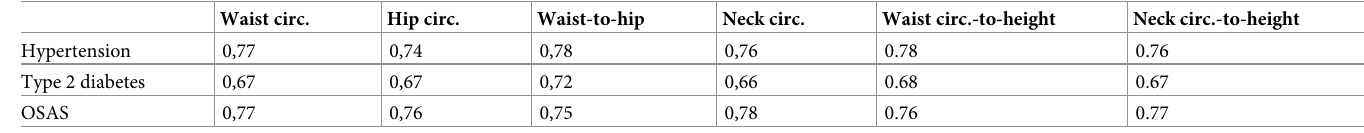
Table 2. Areas under the curve of univariate logistic regressions. Waist circ. Hip circ. Waist-to-hip Neck circ. Waist circ.-to-height Neck